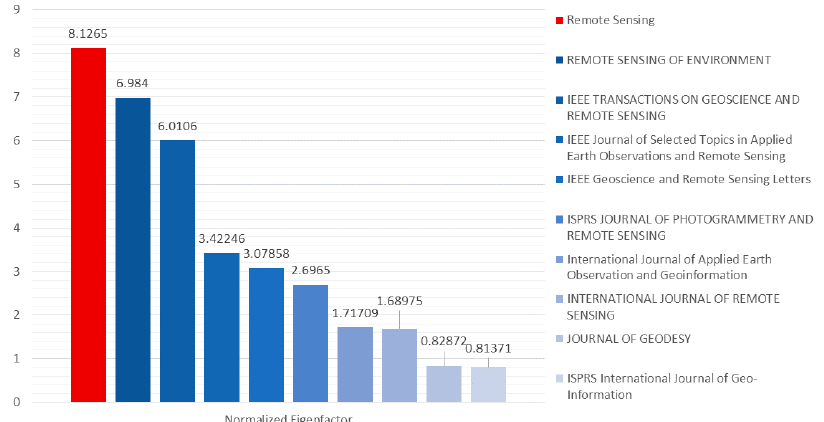
Figure 9. The top 10 journals under the category “Remote Sensing” based on normalized Eigenfactor (2019). Data were calculated from Web of Science on 13 July 2020. Among all of the journals under this category, the Article Influence Score of Remote Sensing OAJ of MDPI (0.927) ranks 9th (Figure 10).